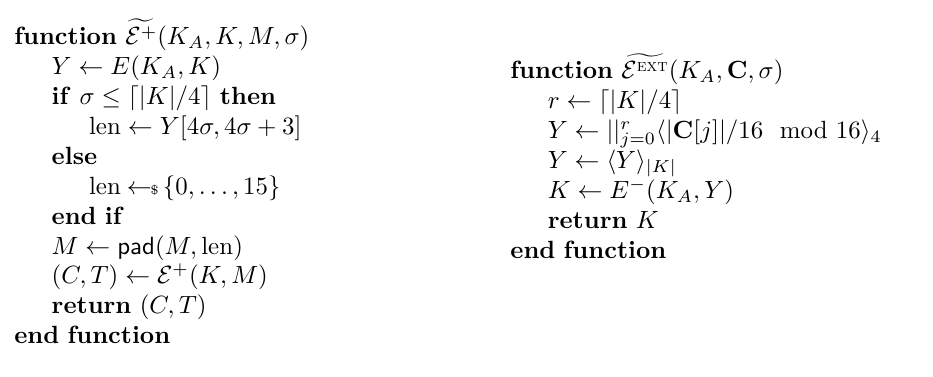
Algorithm 5.1 Pseudocode of our subversion attack. Here σ denotes the internal